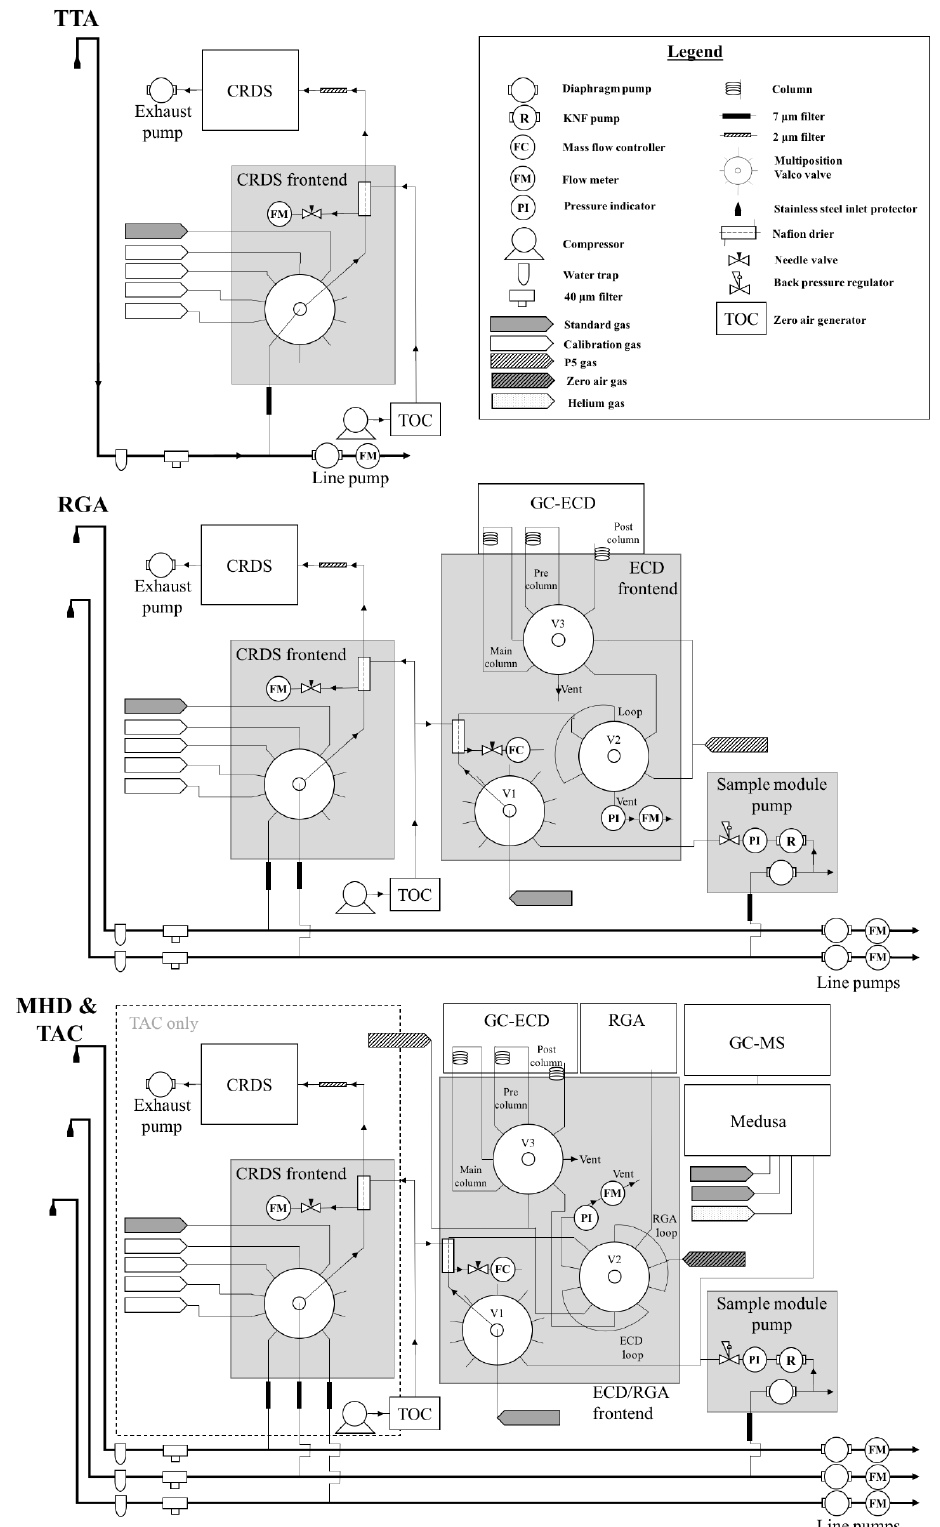
Figure 2. Schematic diagram of the UK DECC network (Angus, TTA; Ridge Hill, RGL; and Tacolneston, TAC) CO 2 , CH 4 , N 2 O, SF 6 , CO and H 2 analysis system. The MHD setup is outlined in Prinn et al.